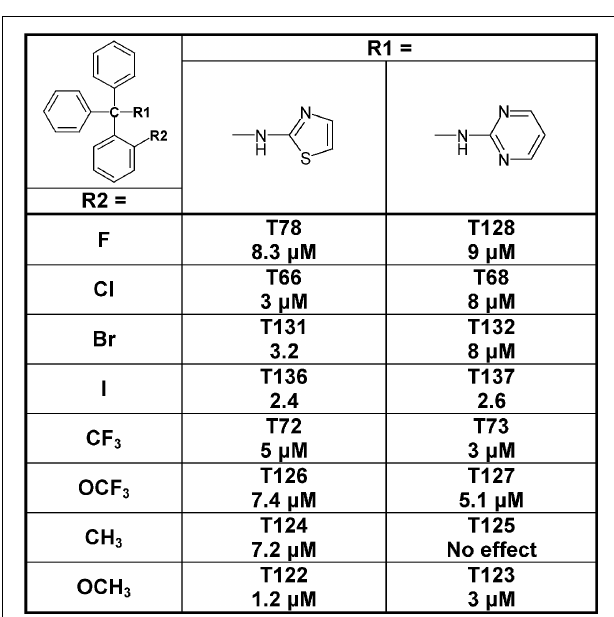
FIGURE 6 |Table showing the structures and IC 50 values for Cx50 inhibition for aminothiazole and aminopyrimdine substituted triarylmethanes with various functional groups in ortho-position on one of the phenyl rings. Means of current inhibition and SD were determined by application of two or three concentrations of each triarylmethane to multiple cells ( n ranging from 3 to 8 per concentration). The SD values are not shown for clarity; SD values typically ranged between 5 and 15%.